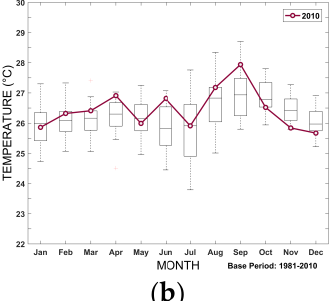
Figure 5. The same as Figure 4 but for Cruzeiro do Sul station in Acre (AC) and for 2010 (blue curve).